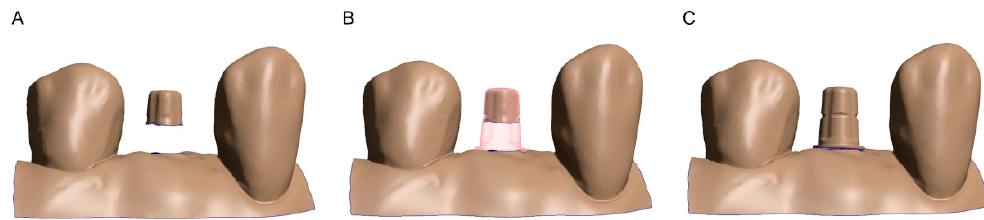
Figure 3. Reconstruction procedure: ( A ) OC 2 with 1.5 mm missing data marginally; ( B ) OC 2 matched with RT; ( C ) both datasets combined.